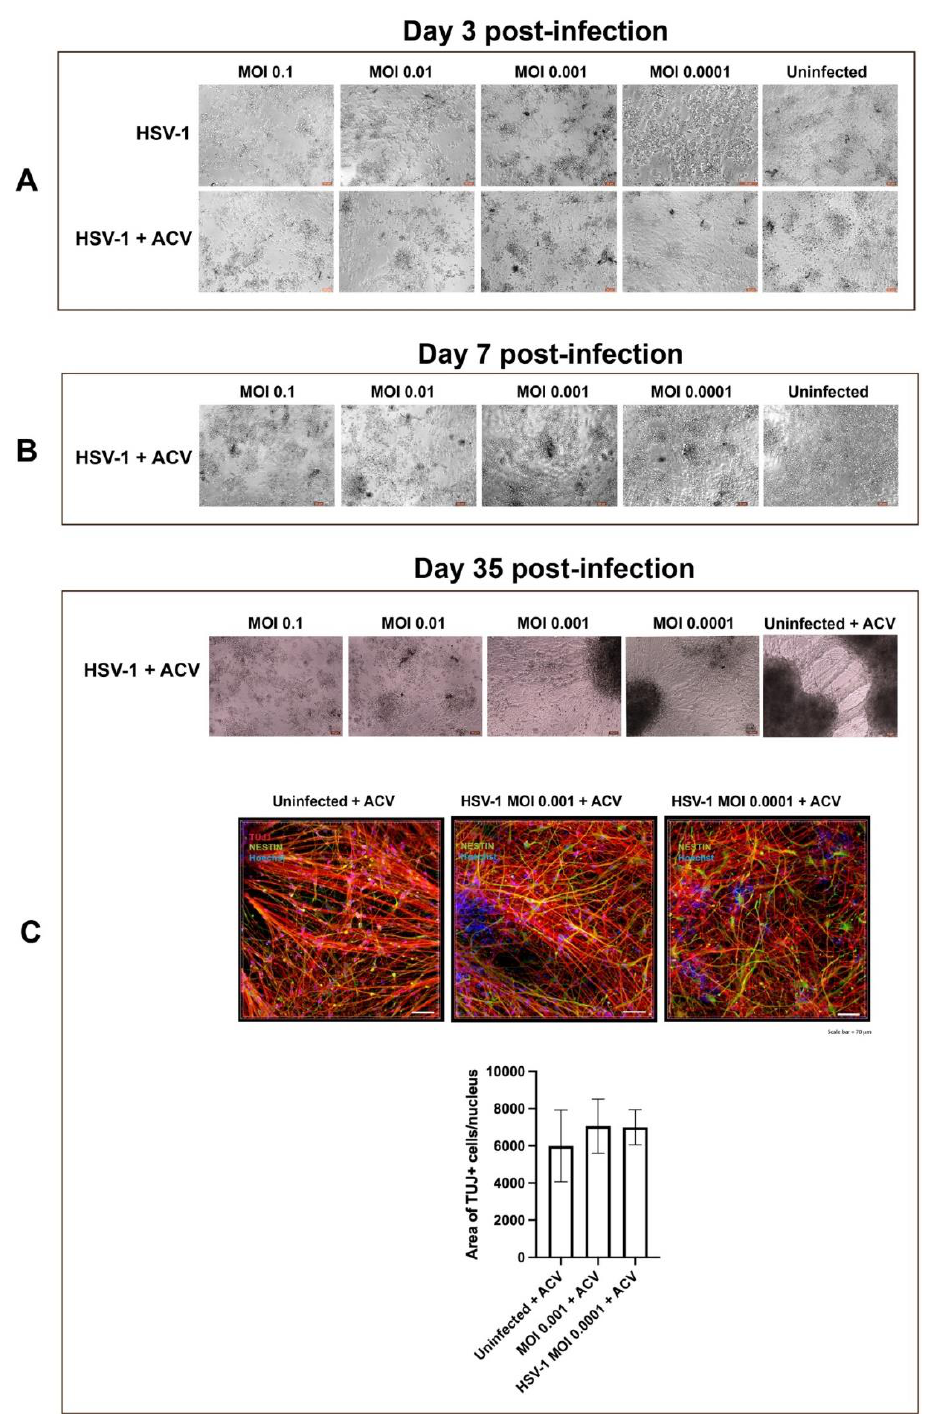
Figure 6. Analysis of neuronal differentiation of NPCs in A-3D cultures in the presence of ACV. A-3D cultures generated from monolayer cultures of NPCs were infected at a range of low multi- plicities of infection (MOI 0.1-0.0001) with HSV-1, strain KOS, in the presence or absence of ACV. Microphotographs on panels A-C depict the different stages of NPCs differentiation on days 3 ( A ), 7 ( B ) and 35 ( C ). Starting from day 7, reduction of effectiveness of ACV was observed in cultures infected at MOIs 0.1-0.01 ( B ). In day 35 p.i. neuronal differentiation was observed only in cultures infected at MOIs 0.001-0.0001 cultured in the presence of ACV ( C ). Next, we investigated whether the failure of the ACV antiviral activity at MOIs 0.1 – 0.01 could be mainly attributable to ACV-resistant mutants, similar to our observations